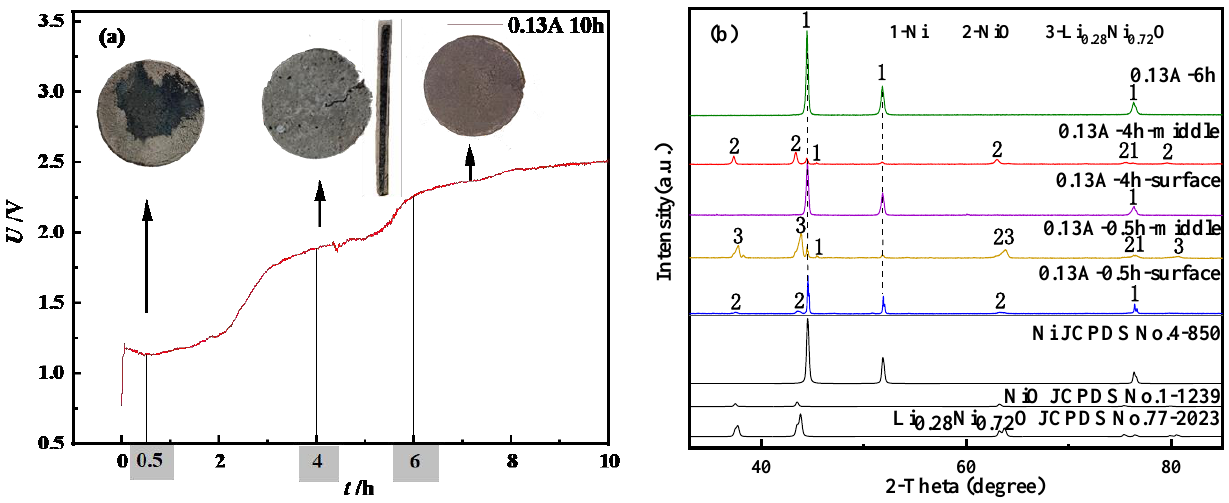
Figure 15. ( a ) 0.13 A U-t curve of 10 h electrolysis ( b ) 0.13 A XRD detection of deoxidation products at different times. The U - t curve is shown in Figure 15a. In the reduction process of Ni 3+ , different re- duction stages correspond to different potential platforms. According to the XRD pattern